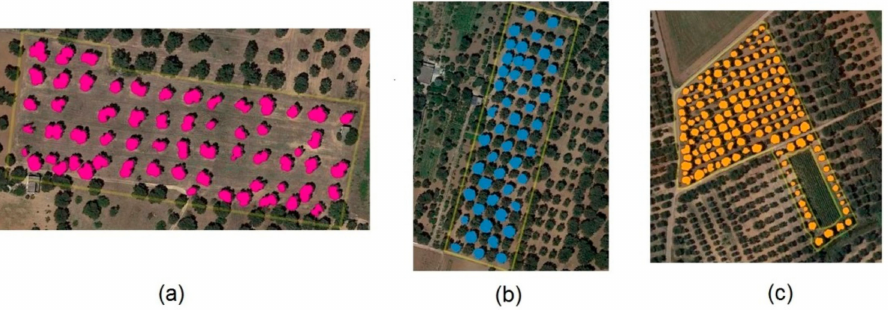
Figure 5. An example of multipolygon product of the three fields on the date of September 2017: Re ( a ), Fella ( b ), and Torchiarolo ( c ).